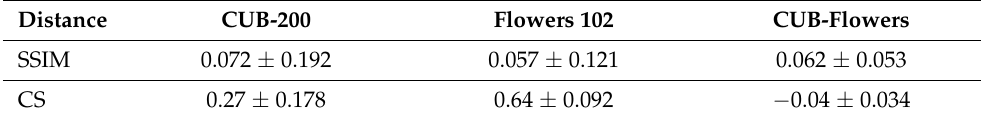
Distance CUB-200 Flowers 102 CUB-Flowers